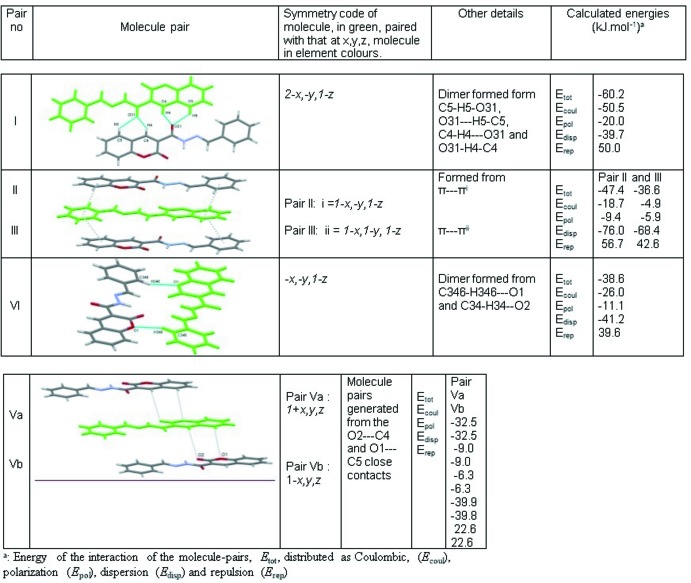
Calculated energies for the most significant mol­ecule pairs in (4: R = C6H5).